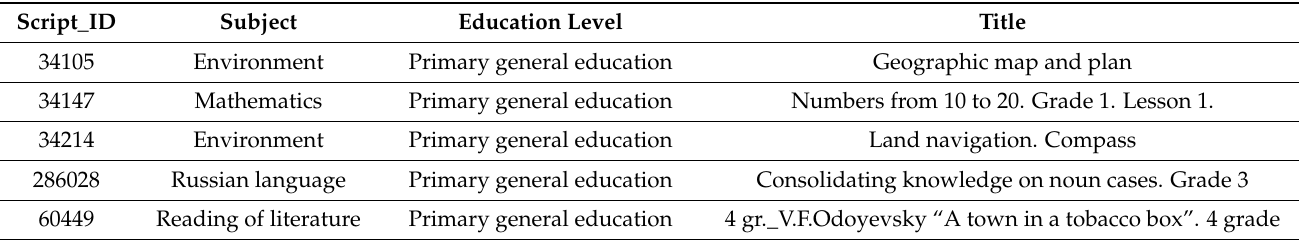
Table 1. Example of the data assigned to a lesson script in the analysis.